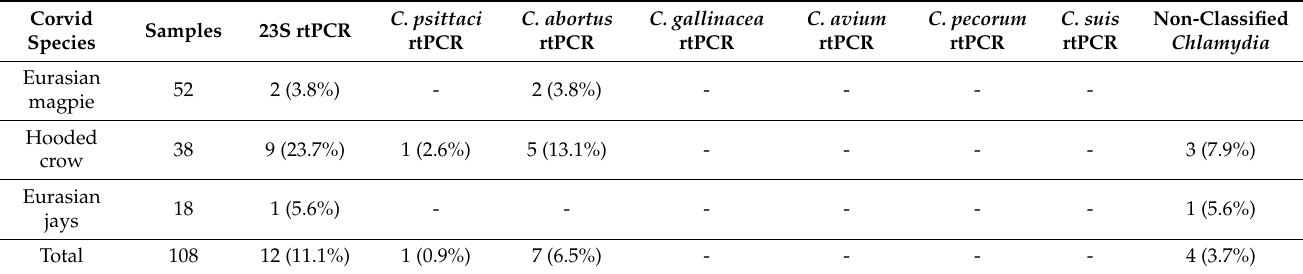
Table 1. Total number and percentage of Chlamydiaceae -positive corvids per species and number and percentage of chlamydial species